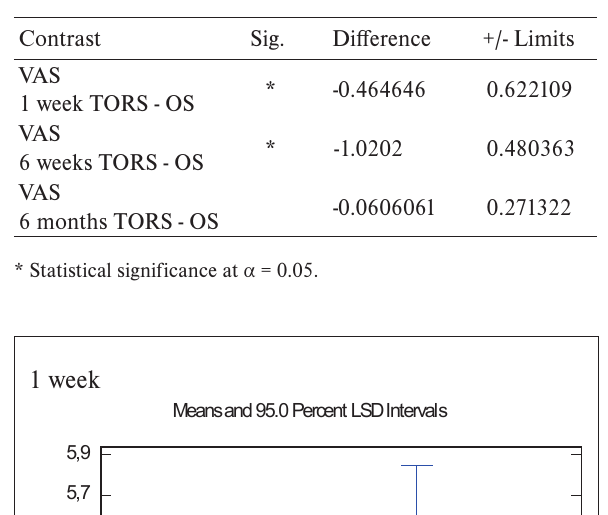
Table 2. mdadi - statistical difference between tested groups Table 3. Vas - statistical difference between tested groups.